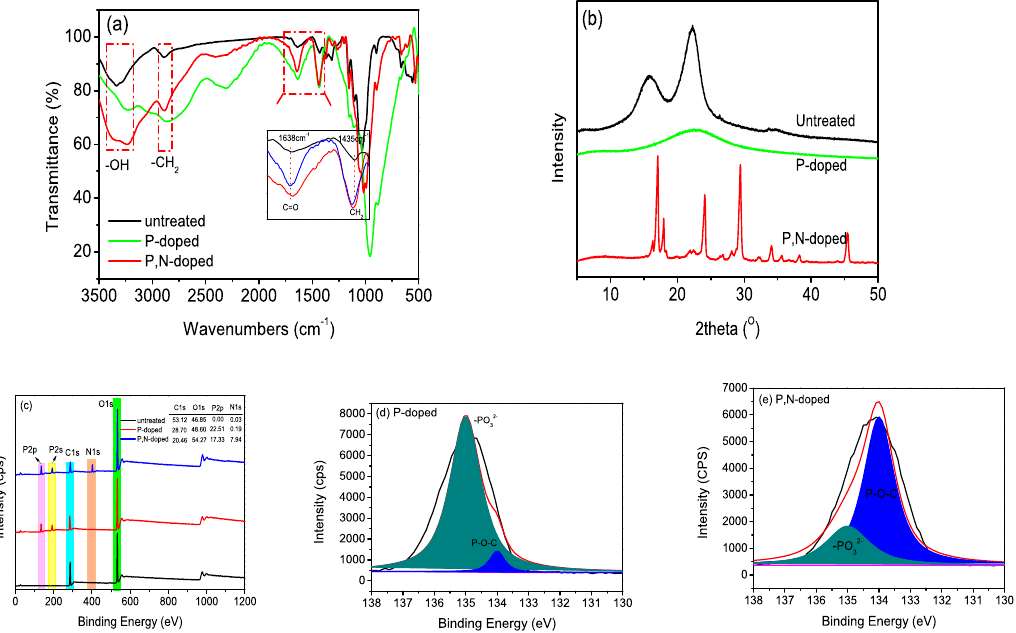
Figure 3. Characteristics of untreated and treated cellulose: ( a ) FTIR spectra, ( b ) XRD spectra, ( c ) XPS survey spectra, and XPS survey spectra of P2p for P-doped cellulose ( d ), and P,N-doped cellulose ( e ).